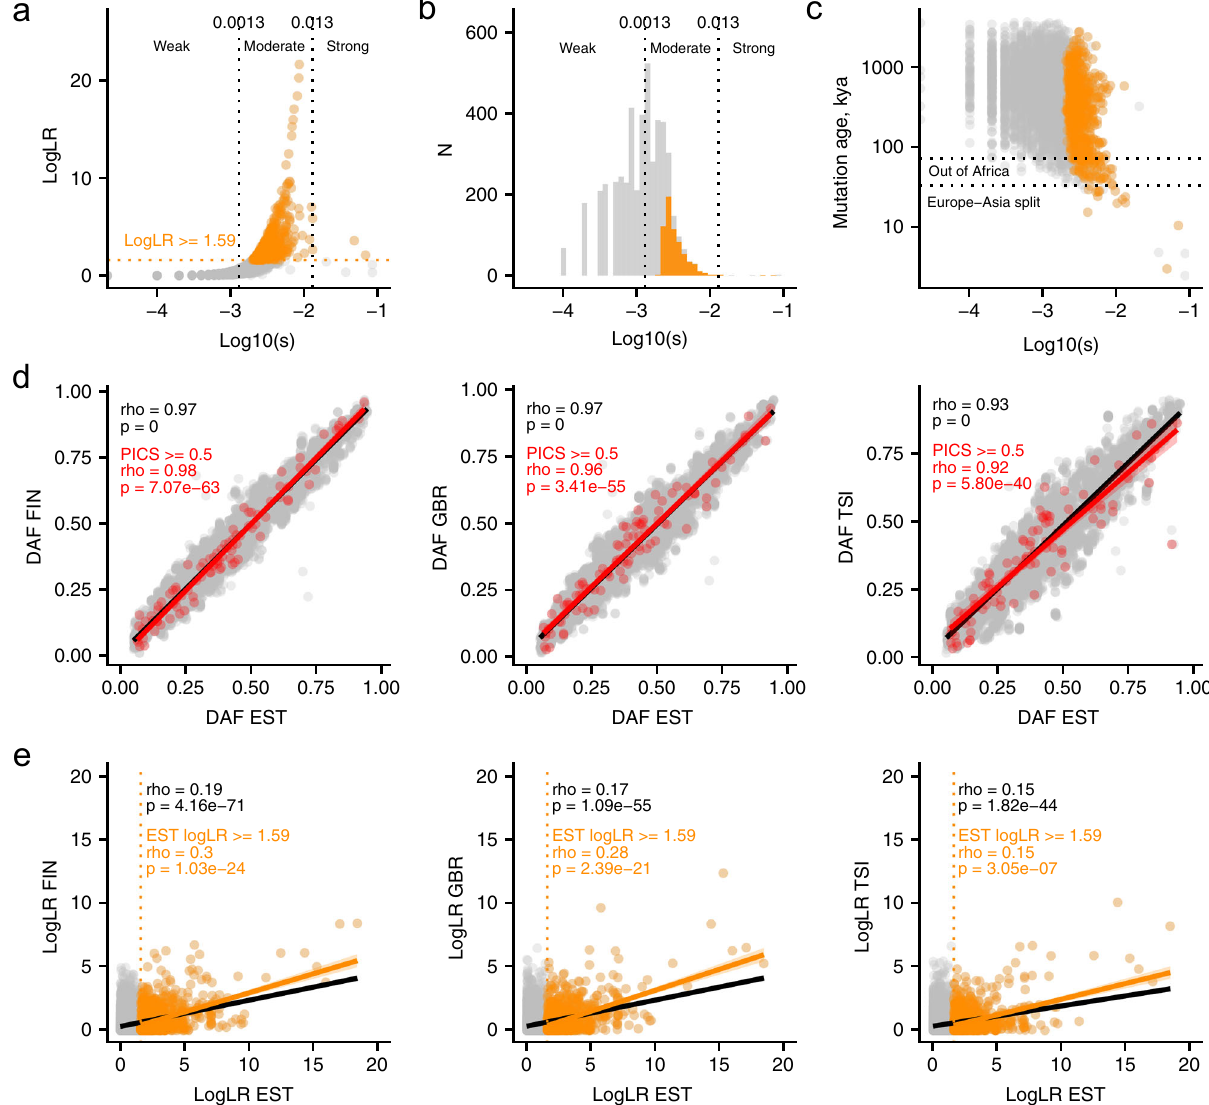
Fig. 1 | Relationship between logLR, selection coef fi cient, and allele age for 9102 candidate SNPs and reproducibility of selection signals between populations. a Evidence for selection (logLR, Log-transformed likelihood ratio of the selection scenario) versus the selection coef fi cient. The horizontal dashed line inorangeindicatestheneutralityrejectionthreshold.Verticaldashedlines(ingray) separate weak, moderate and strong selection coef fi cients, following the Schrider and Kern work 36 . b SNP counts with weak, moderate and strong selection coef fi - cientsamongneutralandsigni fi cantcalls(aboveneutralitythreshold,logLR ≥ 1.59). c DerivedalleleagefortestedcandidateSNPsandtheirselectioncoef fi cients.SNPs with evidence for selection (logLR ≥ 1.59) are shown in orange. d Spearman corre- lation (rho) of candidate SNPs ’ derived allele frequencies between populations; frequencies in Estonians are compared with Finns (FIN), British (GBR) and Italians